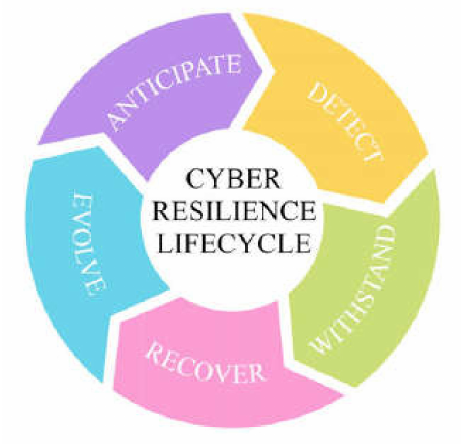
Figure 4. Cyber-resilience lifecycle